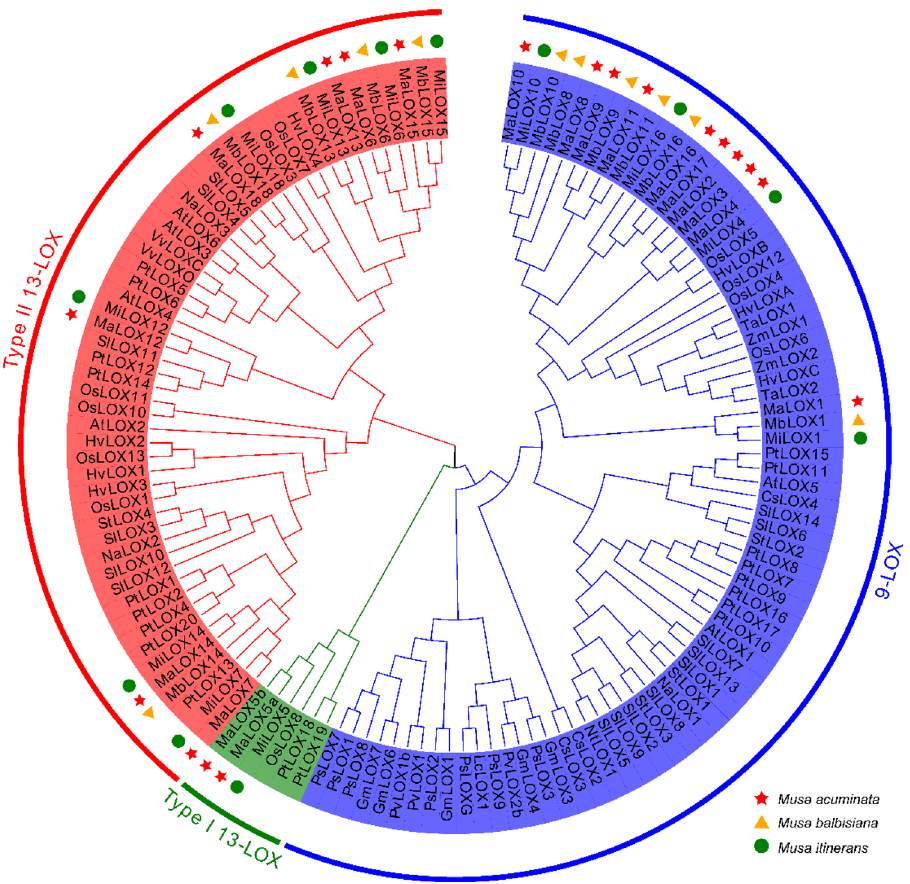
Figure 2. Phylogenetic tree of LOX proteins from M. acuminata , M. balbisiana , M. itinerans and some other plant